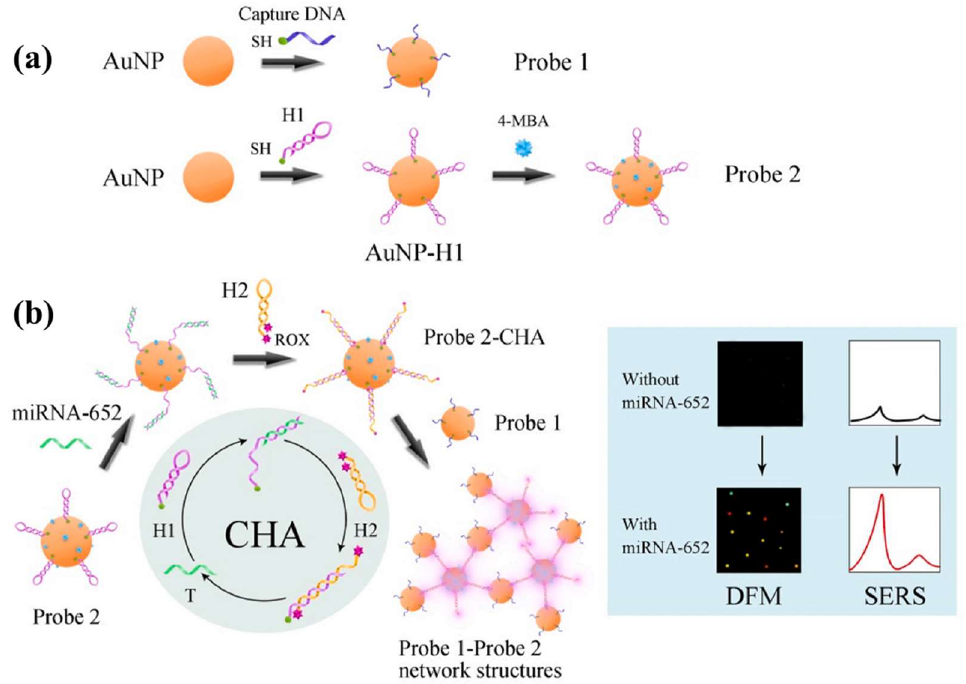
Figure 2. Schematic diagram of SPR/SERS dual-mode plasmonic biosensor based on CHA-induced AuNP network for the detection of miRNA-652. ( a ) Preparation of the Probe 1 and Probe 2. ( b ) SPR/SERS dual-mode sensing strategy based on the CHA-induced AuNP network (Reprinted with permission from Ref. [39]. Copyright 2021, Elsevier).